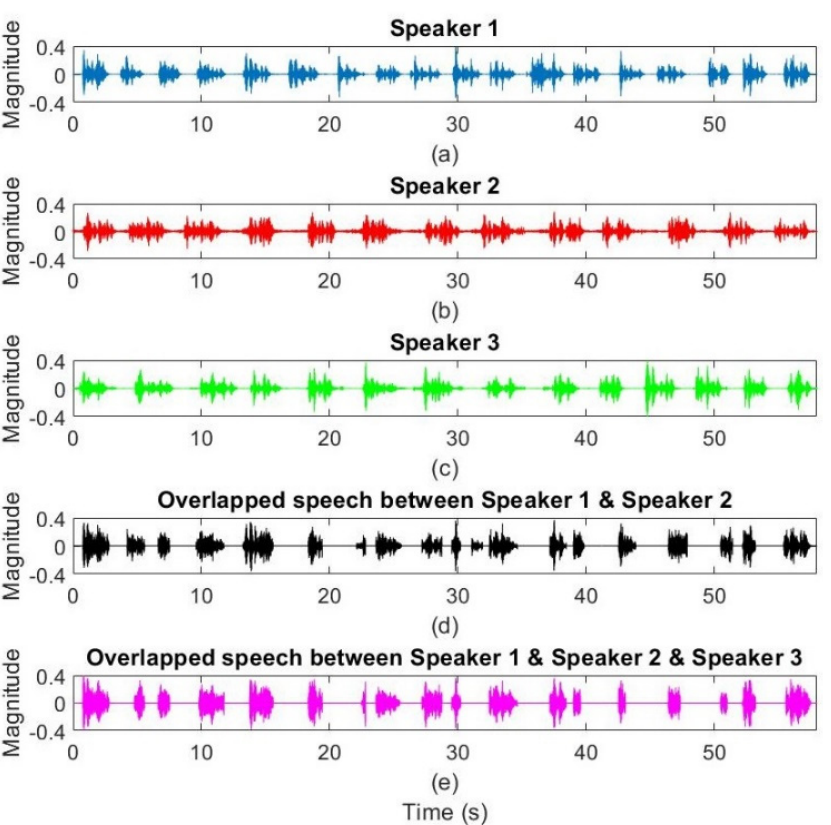
Figure 4. The time-domain speech signal for ( a ) 1st speaker (S1), ( b ) 2nd speaker (S2), ( c ) 3rd speaker (S3), ( d ) overlap between speakers S1 and S2, and ( e ) overlap between speakers S1, S2, and S3.